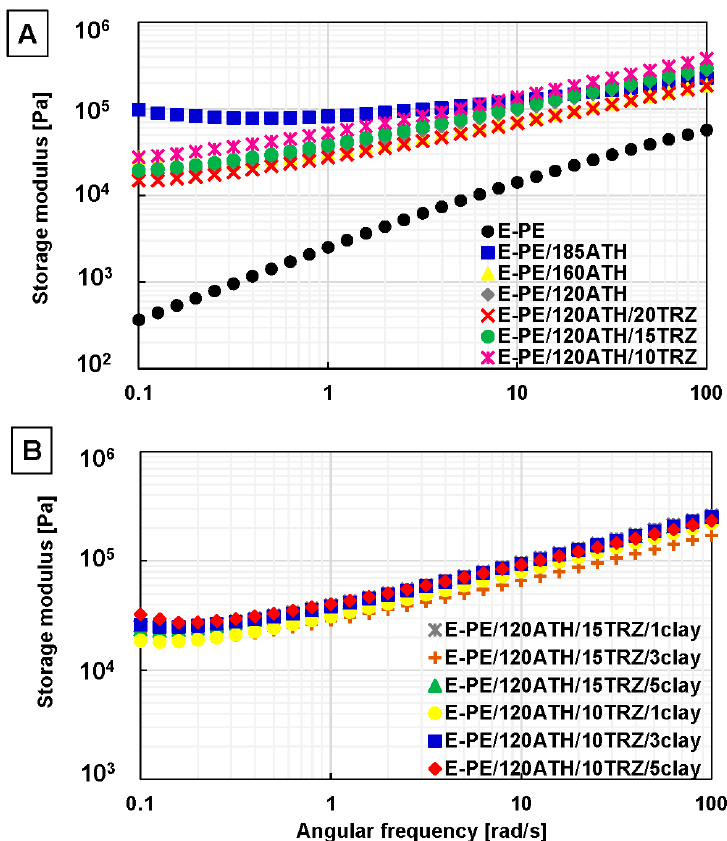
Figure 5. Storage modulus as function of angular frequency in small amplitude oscillatory shear flow (SAOS) flow test for: ( A ) E-PE blend, E-PE/ATH and E-PE/120ATH/TRZ composites using ATH and TRZ at different content, and ( B ) E-PE/120ATH/15TRZ/clay and E-PE/120ATH/10TRZ/clay composites varying clay content.